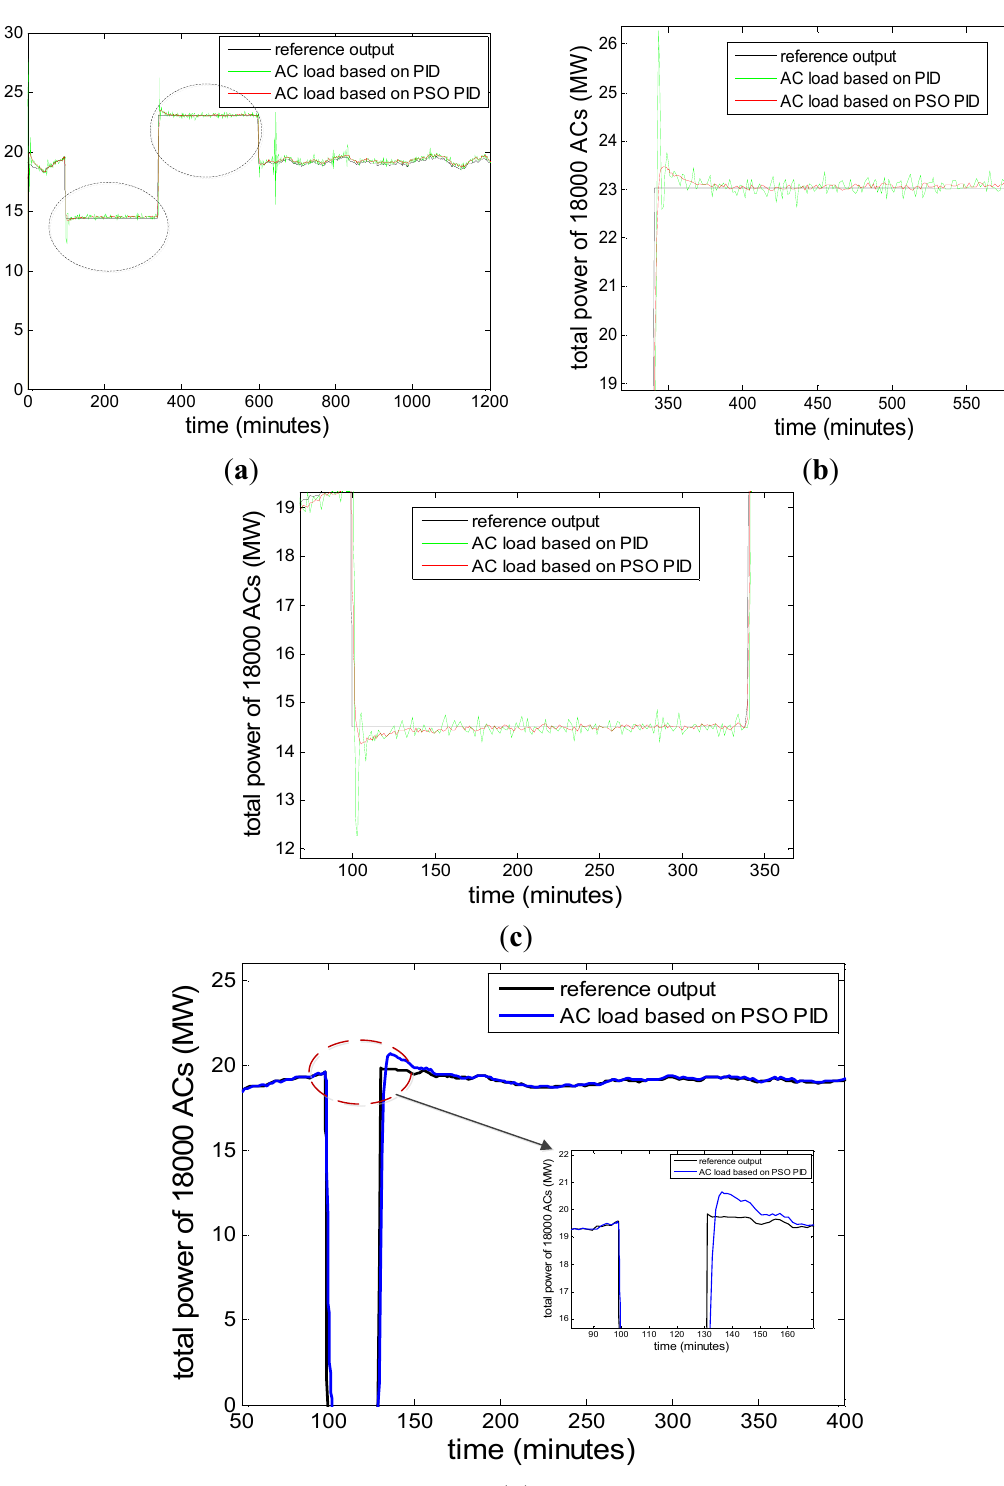
Figure 15. ( a ), ( b ), ( c ) A comparison between the desired reference value of the aggregated demand of a population of ACs for load shifting, the power output of the population based on conventional PID controller, and the power output of the population based on PSO tuning PID parameters, when the outdoor temperature is constantly 32 °C. ( d ) The aggregated demand of n ACs in the extreme case of a 100% load reduction for 30